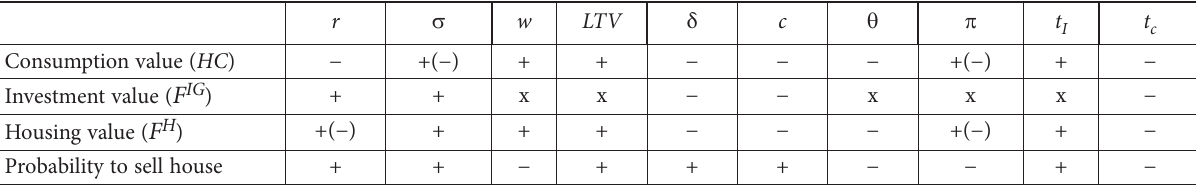
Table 7. Relationship among housing value, probability to sell, and parameters in the model ( r is the risk-free rate; σ is the volatility of housing price index; w is the utility rental benefit rate; LTV is the LTV ratio; δ is the depreciation rate of real estate; c is the expense ratio of maintenance and management; q is the related costs of sale; p is the cost of switching